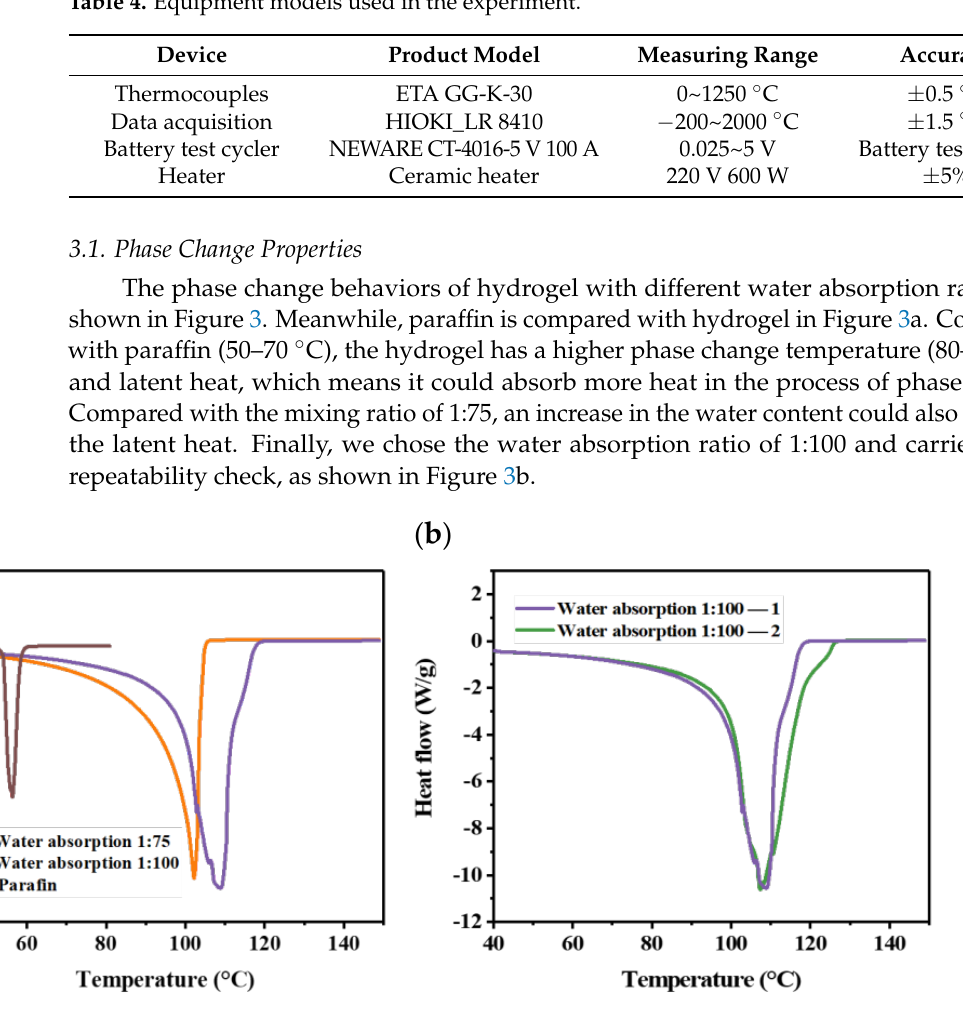
Table 4. Equipment models used in the experiment.